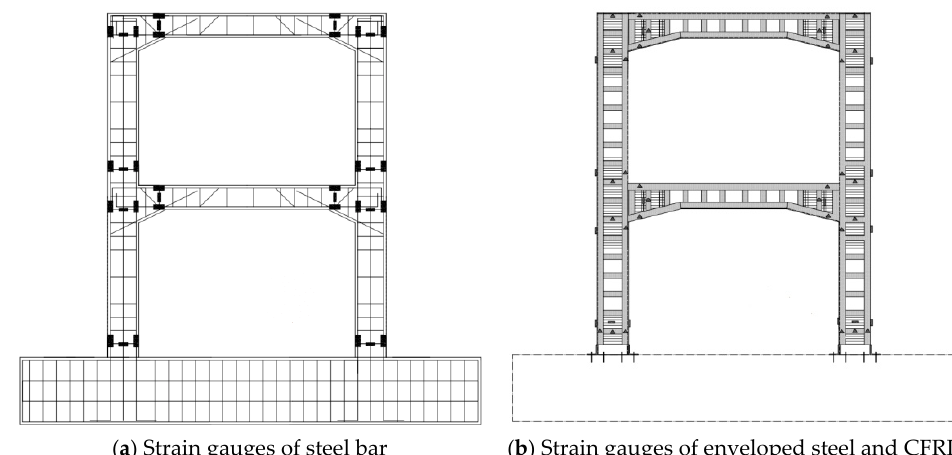
Figure 7. Layout of strain